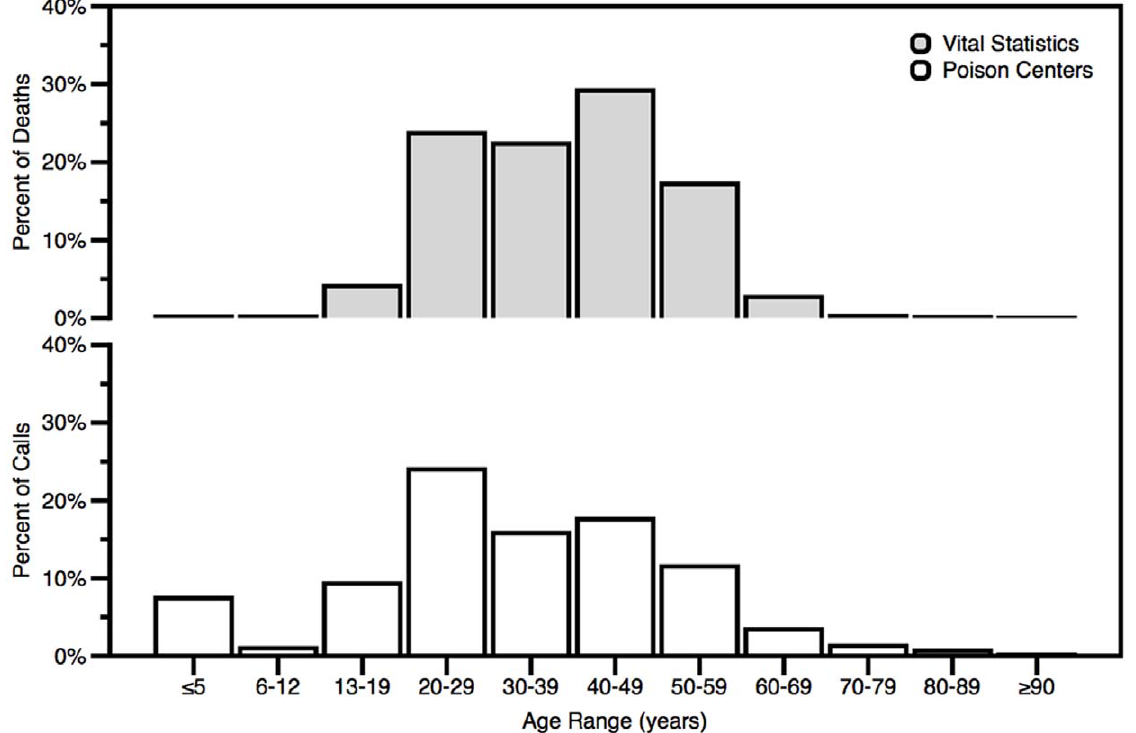
Figure 2. Age distributions for PC calls and poisoning deaths involving methadone, 29 states, 2006–7. Age distributions were similar, although poison center exposure calls were slightly more often about infants and children than overdose deaths reported in vital statistics. Other studies have also documented that emergency medical service utilization tends to involve younger individuals compared to overdose deaths due to prescription opioids in the United States